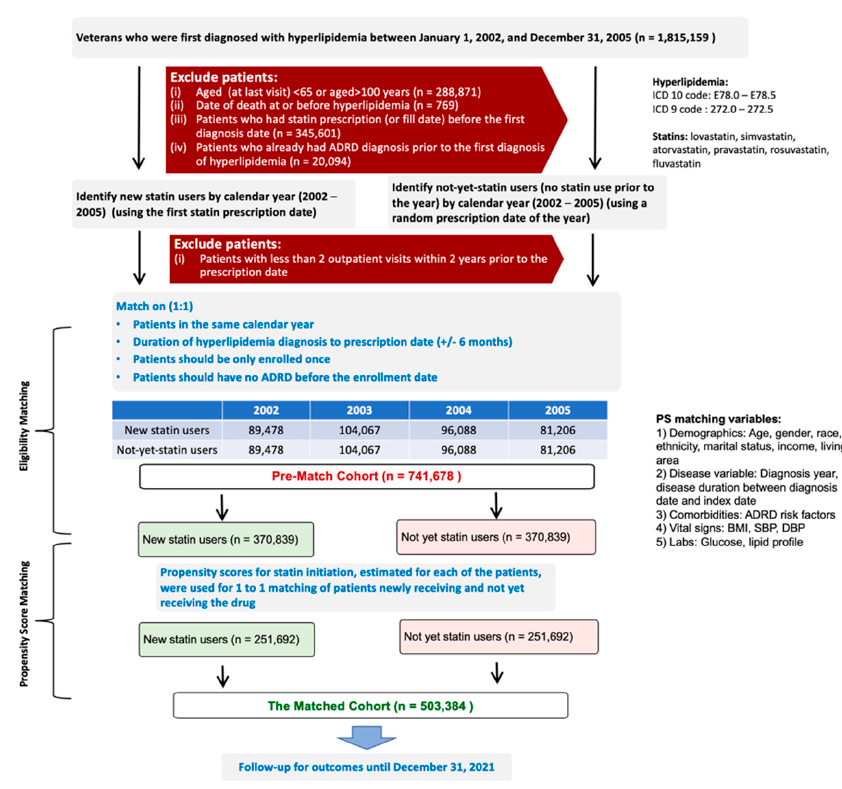
Figure 1. Cohort assembly.